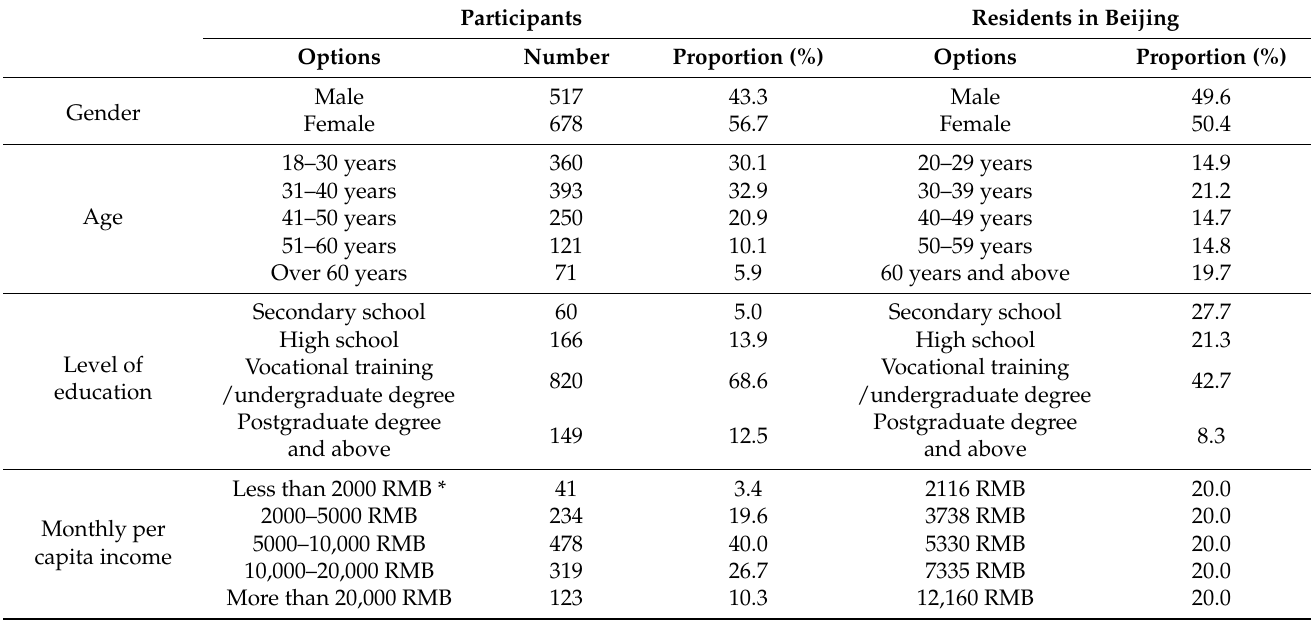
Table 1. Demographic